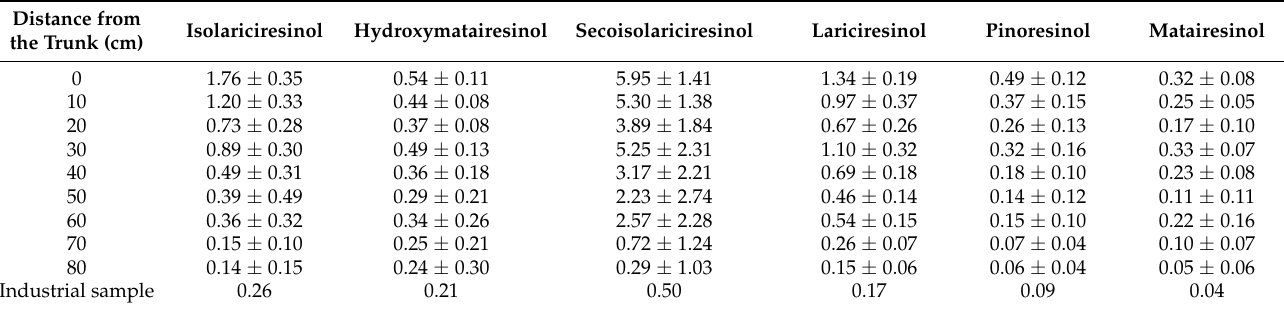
Table 1. Content of individual quantified lignans (mg/g) compared with that at the proximal part of the branch.